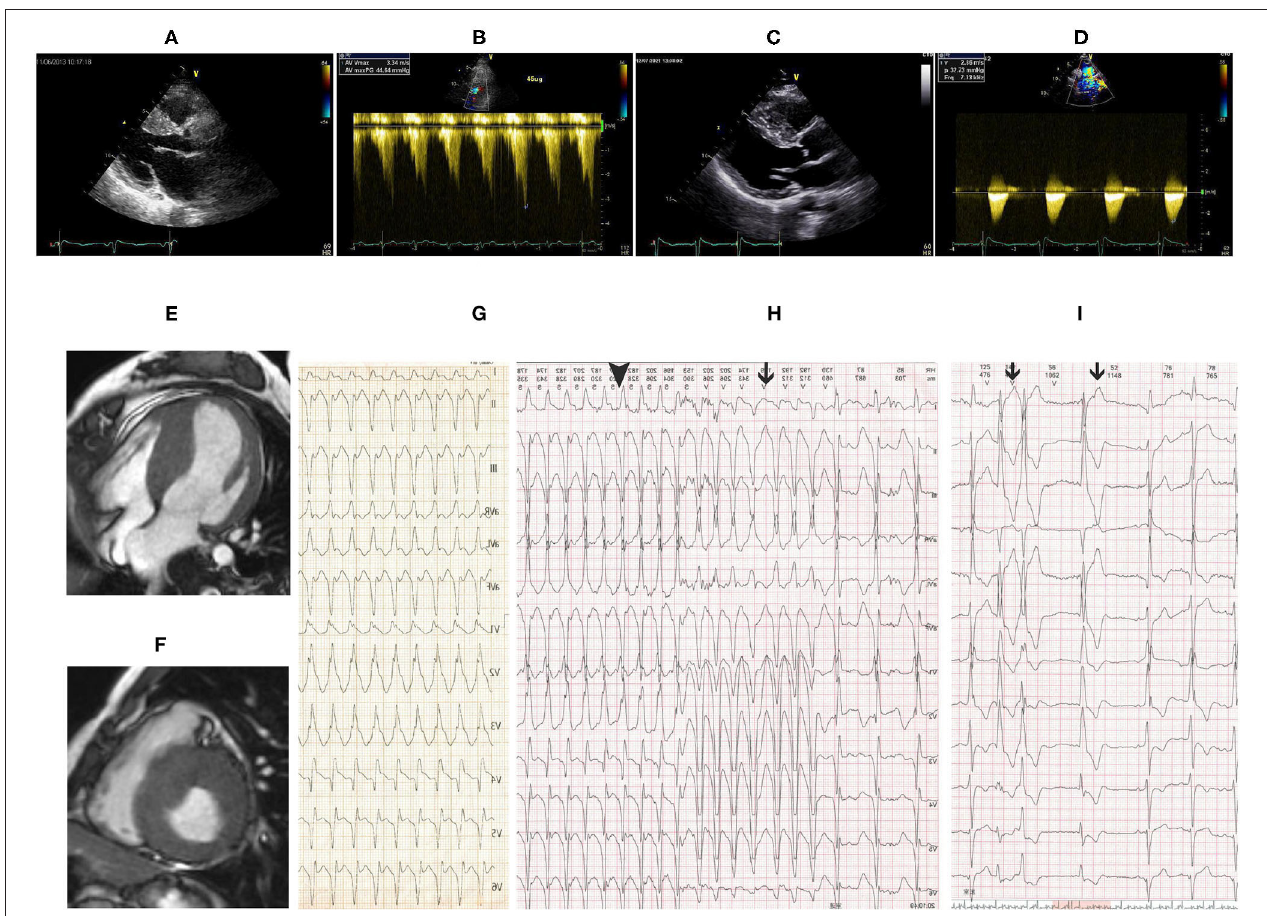
FIGURE 1 | (A) Transthoracic echocardiography (TTE) showed remarkably asymmetric left ventricular (LV) hypertrophy with 23-mm thickness of the interventricular septum and 10-mm thickness of the posterior wall. (B) Pressure gradient of the left ventricular outflow tract (LVOT) was 44 mmHg after dobutamine infusion at a speed of 45 ug/ml. Follow-up TTE 8 years after CoA correction showed similar LV hypertrophy as before intervention (C) and flow velocity at the descending aorta was 2.9 m/s (D) . Cardiac magnetic resonance imaging (MRI) showed asymmetric LV hypertrophy in (E) apical 4 chamber view and (F) short-axis view. (G) Twelve-lead echocardiogram (EKG) showed supraventricular tachycardia with right bundle branch block (RBBB) at a heart rate of 190 bpm. Holter monitor (H,I) revealed non-sustained ventricular tachycardia (black line in H), supraventricular tachycardia with RBBB (black triangle in H), and premature ventricular beats (black line in